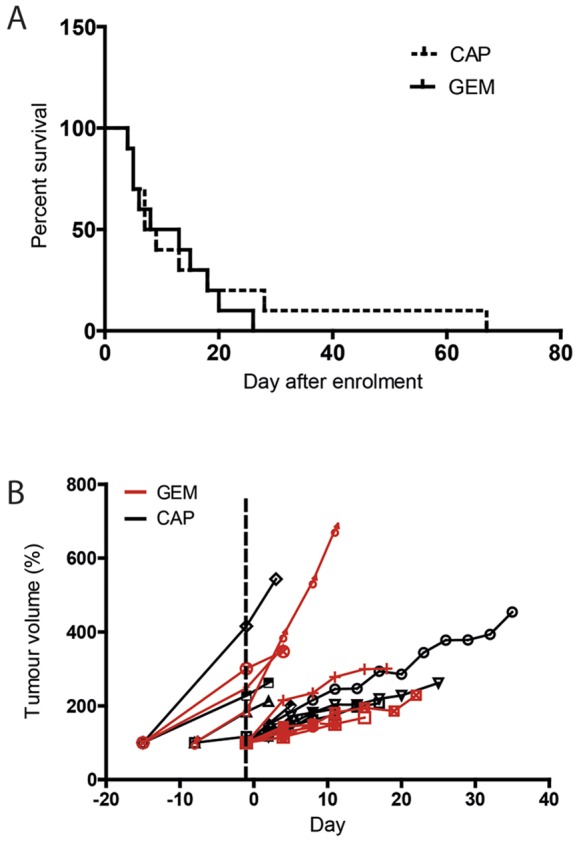
Comparison of CAP and GEM on KPC mice survival.(A): Kaplan-Meier curves for capecitabine (hatched) and gemcitabine (solid) survival. P = 0.61 Log-Rank test, Hazard Ratio = 0.78, 95%CI 0.29 to 2.06 (n = 10 per group). (B): Individual growth curves for CAP- (black) and GEM-treated tumours (red). Volumes were normalized to the volume at the day of the enrolment in the survival study.